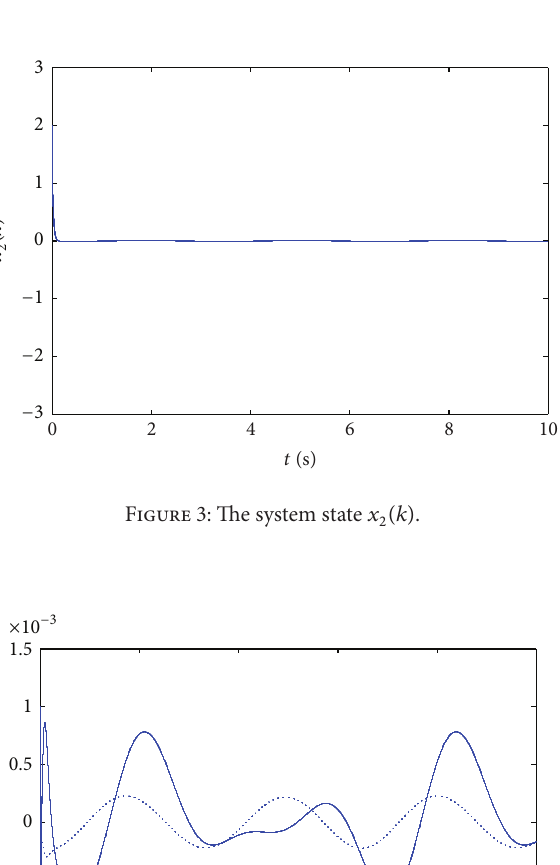
Figure 2: The system state 𝑥 1 (𝑘) .